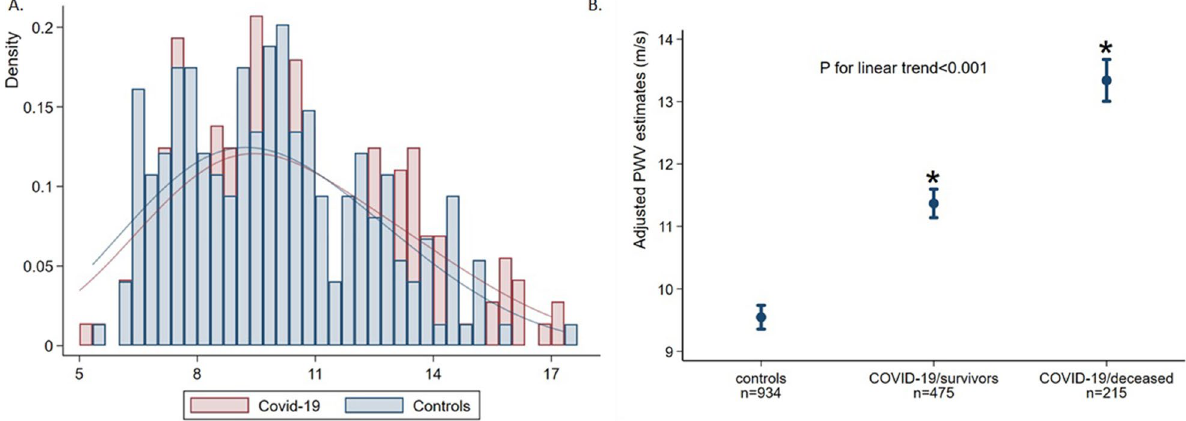
Figure 1. ( A ) Histogram and Kernel Density Estimates of the ePWV in patients with COVID-19 and controls after propensity matching for age, sex, smoking, hypertension, CKD, diabetes mellitus, smoking, history of CVD and hyperlipidemia. ( B ) Difference in ePWV among control subjects without COVID-19, COVID-19 patients who were discharged from hospital and 28-day deceased patients with COVID-19. Estimates of ePWV are adjusted for sex, hypertension, CKD, DM, smoking, history of CVD and hyperlipidemia. Circles represent mean value of ePWV per group and bars the 95% confidence intervals. Asterisks indicate significant ( P < 0.001) difference from the reference category (i.e., controls from the Athens Vascular Registry). CKD: chronic kidney disease, DM: diabetes mellitus, CVD: cardiovascular disease, including history of coronary artery disease and/or heart failure, PWV: pulse wave velocity. Precision Accuracy Recall (Sensitivity) (PPV) AUC